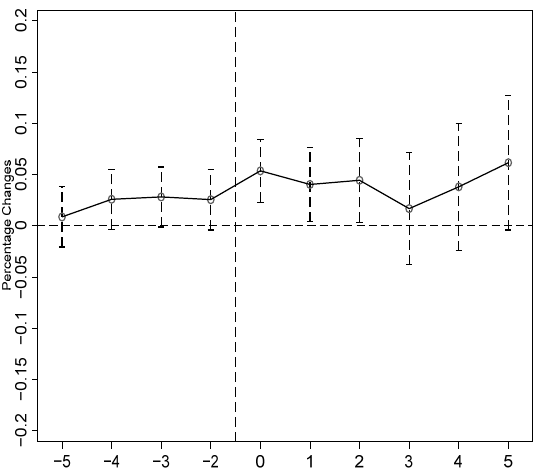
Figure 3. Parallel trend and dynamic effect test of the impact of FTZ policy on GTFP.